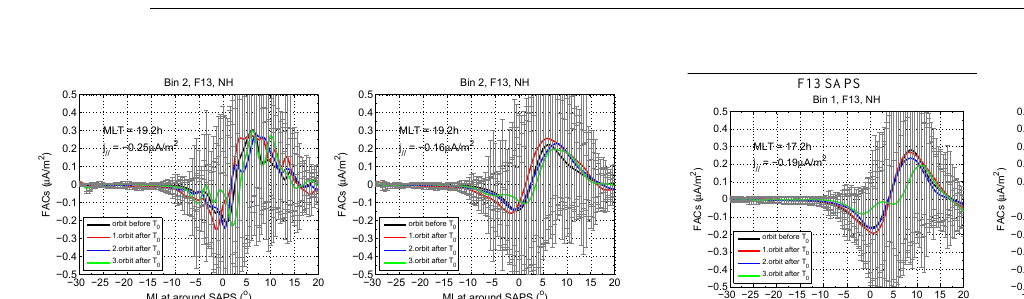
−30 −25 −20 −15 −10 −5 0 5 10 15 Figure 2. Superposed epoch analysis of large-scale FACs in bin 2 Fig. 2. Superposed epoch analysis of large scale FACs in bin 2 for DMSP F13 SAPS event (left 20s averaged FACs, right filtered data). Positive denotes upward FACs flowing out of the ionosphere. Black line: orbit arc for the DMSP F13 SAPS event (left: 20s averaged FACs, right: beforeSAPS;redline: 0-0.5hafterSAPS;blueline: 1.5-2hafterSAPS;greenline: 3-3.5hafterSAPS.Standard filtered data). Positive denotes upward FACs flowing out of the deviationsaremarkedbyverticalbars. ionosphere. Black line: orbit arc before SAPS; red line: 0–0.5h af- ter SAPS; blue line: 1.5–2h after SAPS; green line: 3–3.5h after SAPS. Standard deviations are marked by vertical bars. 16